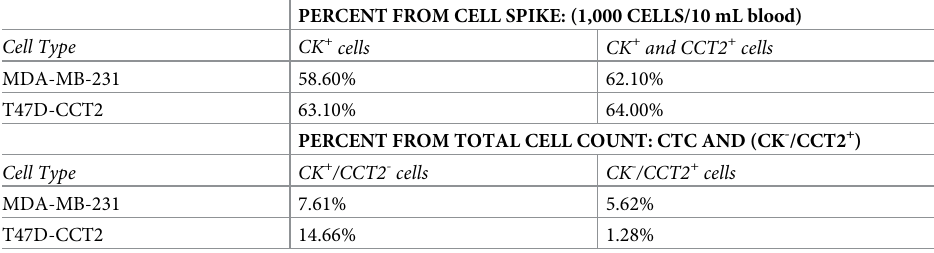
Table 4. Recovery of breast cancer cells spiked in blood and analyzed with the CSS Analyzer